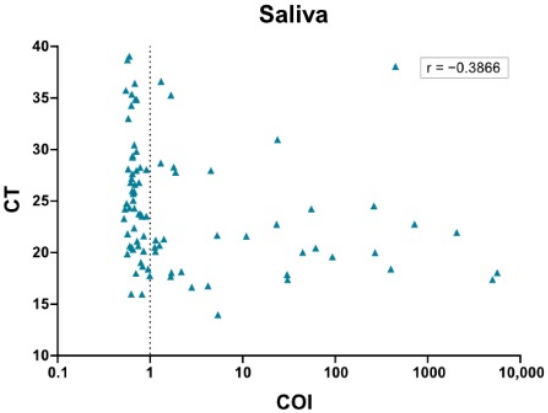
Figure 2. Analysis of correlation between Roche Elecsys Anti-SARS-CoV-2 Antigen assay and cobas SARS-CoV-2 IVD test for saliva samples based on Ct values of corresponding NPS. Spearman correlation between Elecsys Anti-SARS-CoV-2 Antigen assay COI values ( X axis, log scale, cutoff indicated by dotted line) and cobas SARS-CoV-2 IVD test Ct values of the corresponding NPS ( Y axis) was analyzed for saliva samples (N = 87, p = 0.0002). Table 5. PPA of the Roche Elecsys Anti-SARS-CoV-2 Antigen assay with the Roche cobas SARS-CoV-2 IVD test in saliva based on Ct values of corresponding